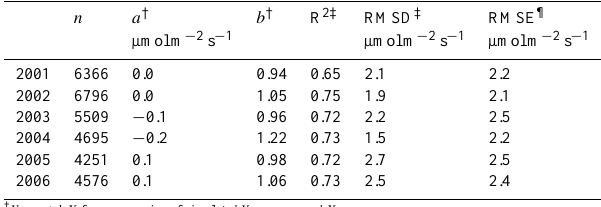
Table 1. Statistics from regressions of simulated on measured ( a , b ), and measured on simulated ( R 2 , RMSD), hourly CO 2 fluxes over a boreal fen at Lost Creek, WI. All measured values were recorded at u · > 0.2ms − 1